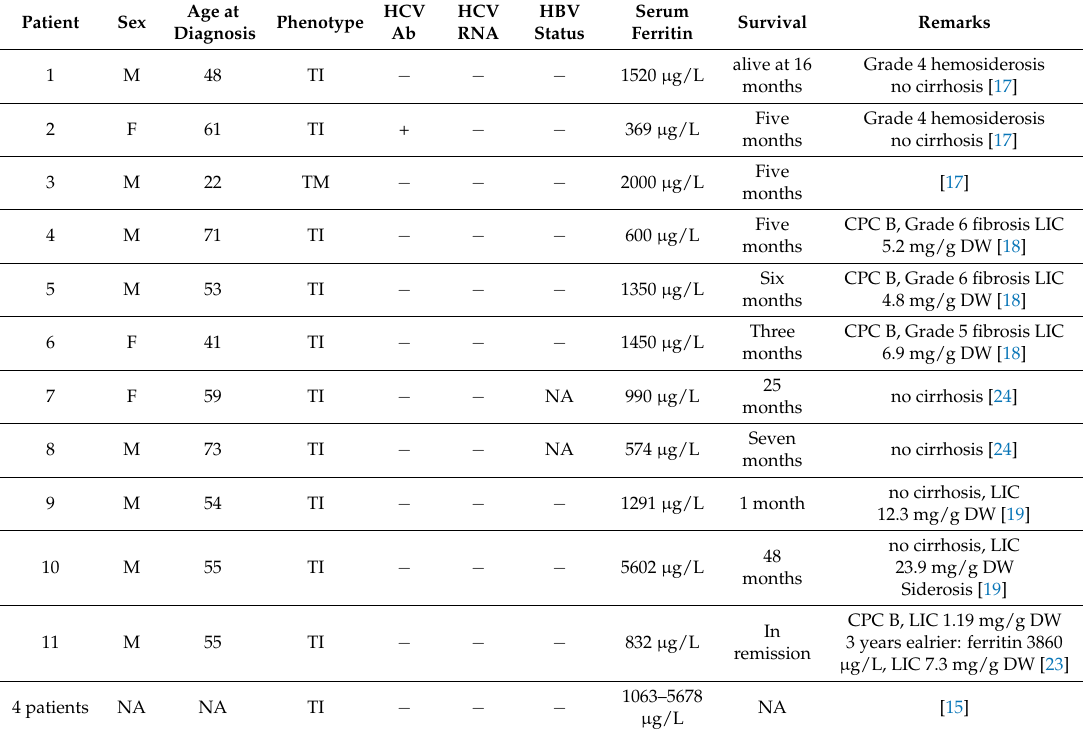
Table 1. Summary of data on hepatitis-negative thalassemic patients who developed hepatocellular carcinoma.